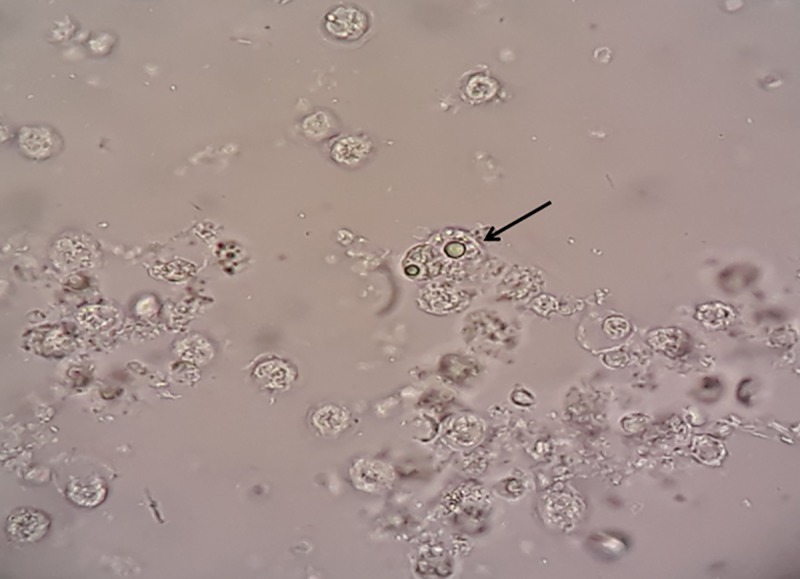
Microscopic image of trophozoite along with the pus cells.